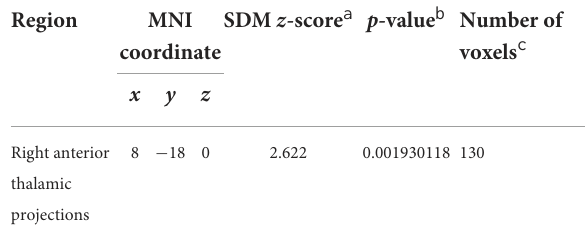
TABLE 6 Meta-regression analysis of MMSE scores in treatment